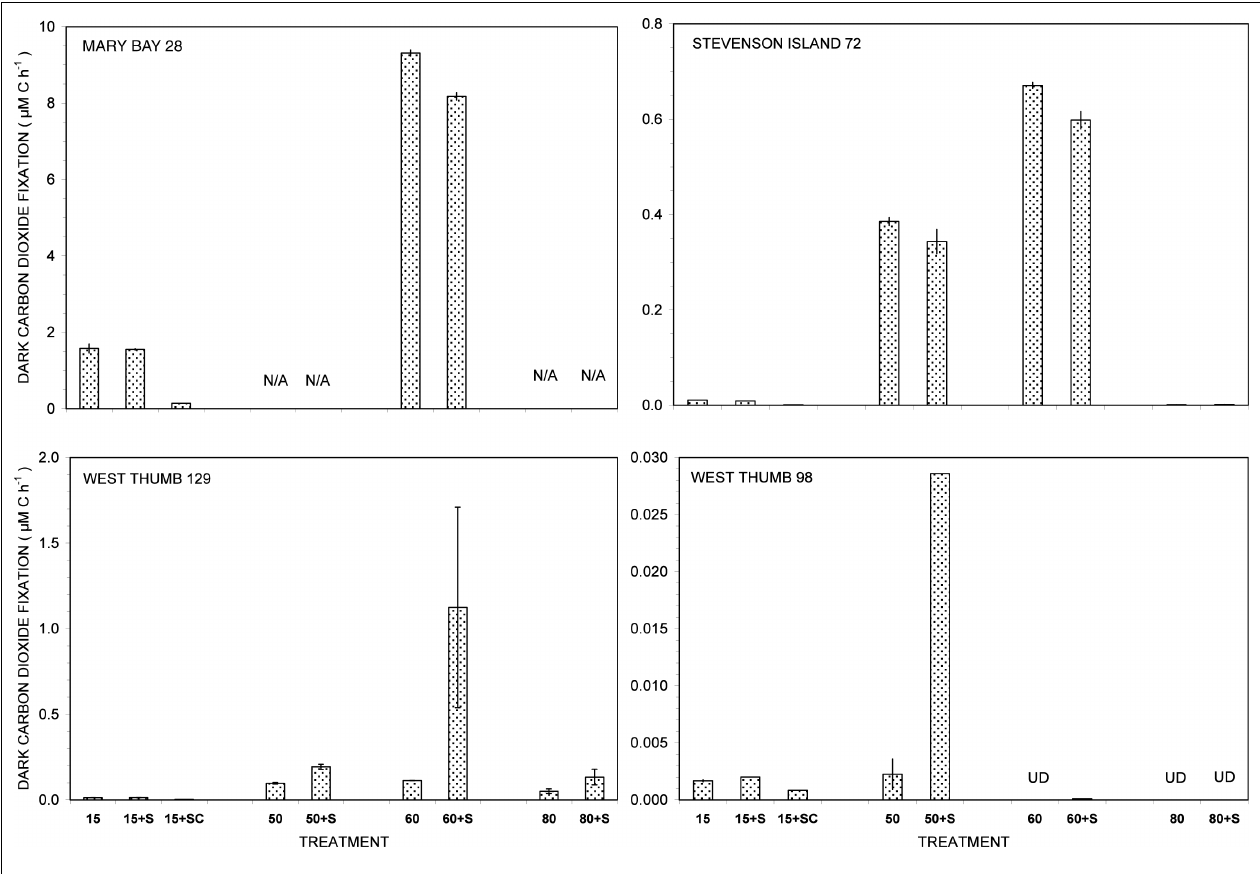
FIGURE 1 | Darkcarbon dioxide fixation byYellowstone Lake hydrothermal vent samples measured in triplicate (15˚C) or duplicate incubations (50, 60, and 80˚C) with ( + S) or without addition of 5mM